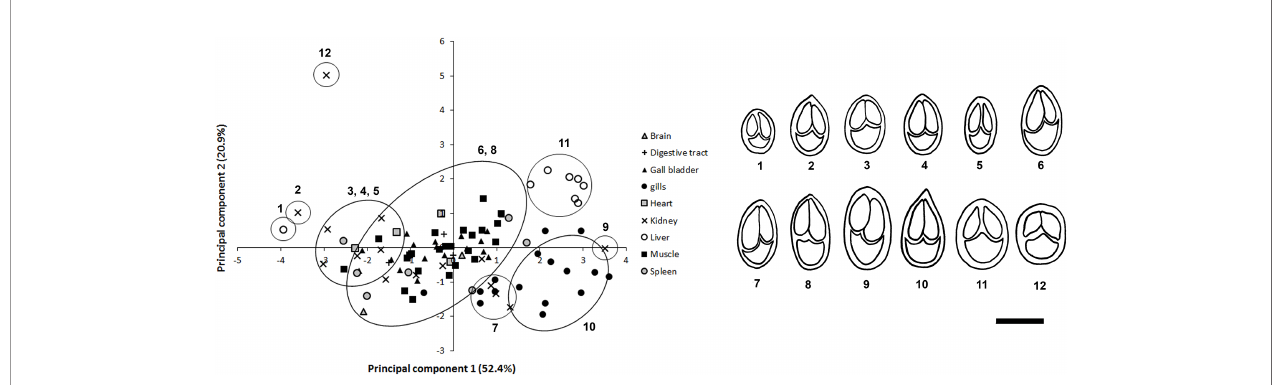
FIGURE 1 | Principal Component analysis (PCA) of mature Myxobolus spores found in tissue samples from gold fi sh. Drawings for 12 morphologically distinct spores are provided in congruence with the PCA analysis. Principal Component 1 (spore length) explained 52.4% of variation, while Principal Component 2 (spore width) explained 20.9% of variation. Scale bar = 10